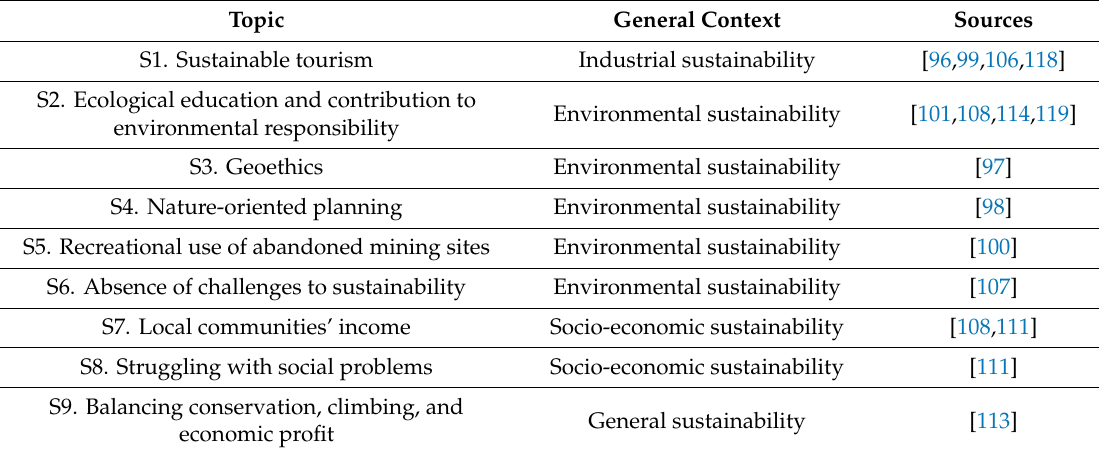
Table 3. Sustainability-related topics of the reviewed